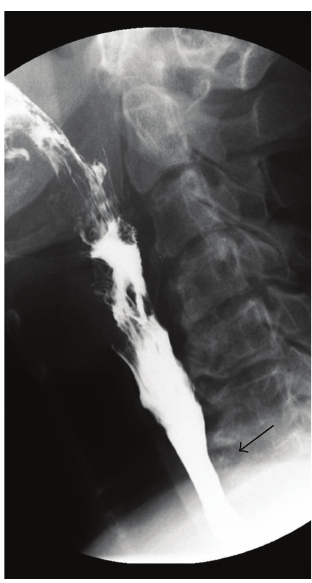
Figure 2: Lateral view of barium swallowshowinga mild narrowing of the esophageal lumen (arrow) at the level of the thoracic inlet.